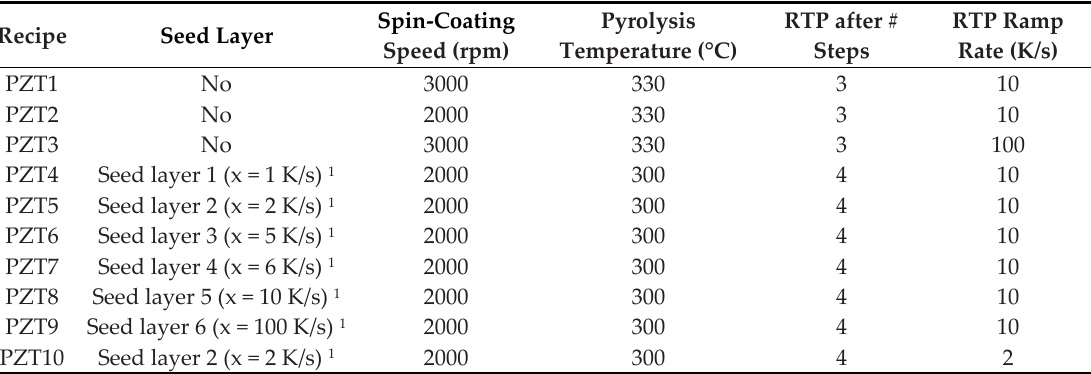
Table 1. The parameters of different recipes used for the PZT deposition.